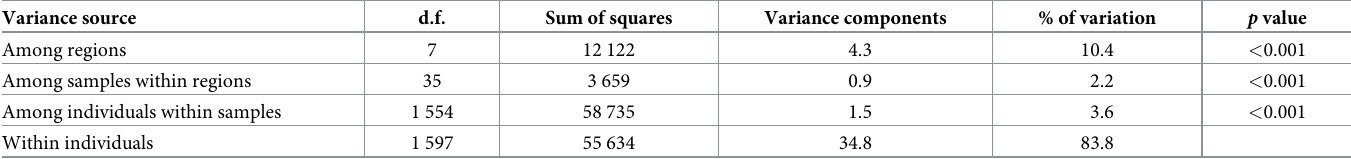
Isfjorden. Also, Kattegat in the Baltic transition zone, the English Channel, Iceland and three fjords in southwestern Norway showed separation from their neighboring samples (Fig 2). In the West Atlantic, US and Canadian samples differed from Greenland ( F � 0.07) and from ST each other with a genome-wide mean F of ~ 0.026. Within Greenland, samples north and ST south of 65˚N were genetically different ( F � 0.021). ST In the Arctic, Isfjorden stood out as highly differentiated from the samples collected off- shore from Svalbard and the Barents Sea area, as well as from northern Norway and Iceland (Table A in S4 Table). Instead, Isfjorden shared a close resemblance with western Greenland (Fig 2). Lumpfish from the Baltic Sea formed a highly distinct genetic group. Fish collected in the English Channel also formed a distinct group. Among the remaining East Atlantic samples, lumpfish collected from the Kattegat area, Iceland, and southwestern Norwegian fjords (Sog- nefjorden, Hardangerfjorden and Boknafjorden) each formed separate clusters. Lumpfish from the rest of Norway, Outer Hebrides, North Sea, Skagerrak, and open Arctic waters Table 3. Distribution of genetic variance of lumpfish ( Cyclopterus lumpus ) for 139 targeted SNPs. Samples are equal to sets of individuals collected at the same site at the same time point, and the regions represent the geographic proximity of sampling sites, as described in Table 1. Variance